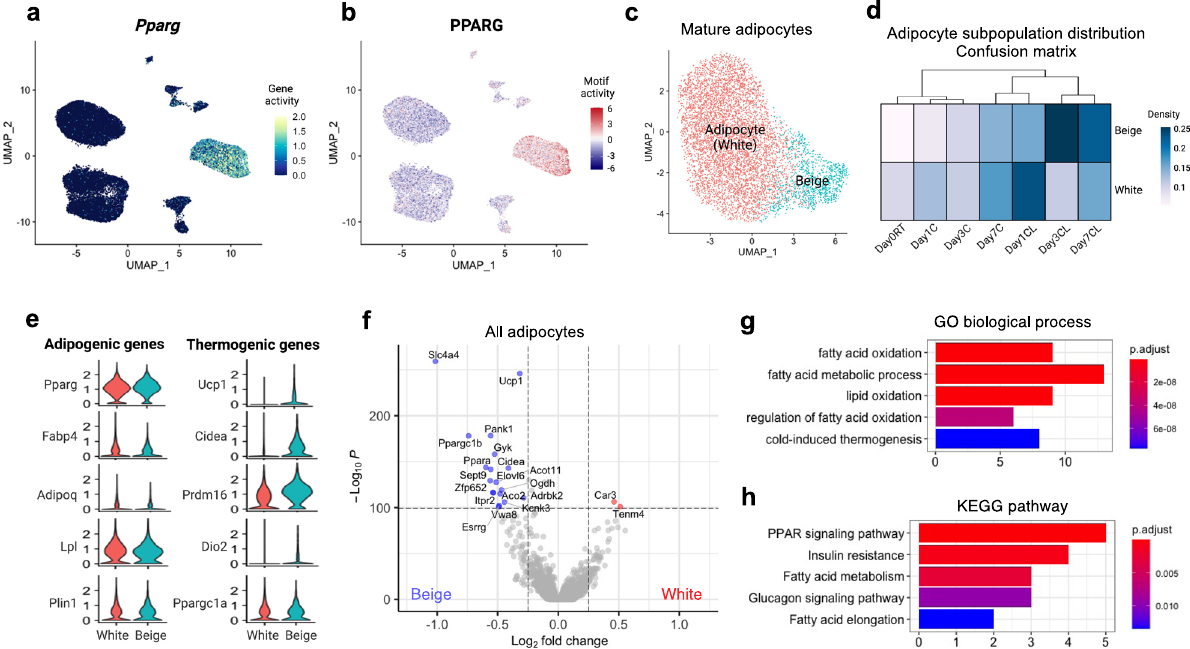
Fig. 2 Identi fi cation of beige adipocytes within mature adipocytes. a UMAP plot of normalized Pparg gene accessibility. b UMAP plot of normalized PPARG motif enrichment. c UMAP plot of white and beige adipocytes among mature adipocytes ( n = 7,004). d Heatmap of the relative cell abundance in white and beige adipocyte clusters for each group. e Normalized accessibilities of adipogenic or common adipocyte genes and thermogenic or beige- selective genes. f Differentially accessible genes between white and beige adipocytes. Positive and negative log2-fold changes respectively indicate increased accessibility in white and beige adipocytes. Genes with adjusted p -value < 10 − 100 & Abs(log2 fold-change) > 0.25 are colored and labeled. g , h GO g and KEGG pathway h analysis of genes enriched in beige adipocytes compared to white adipocytes. X-axis indicates number of genes. Color indicates adjusted p